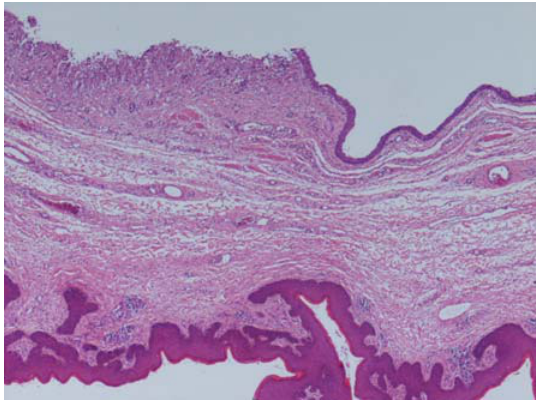
FIGURE 2 . Epidermis covering the polyp is seen at the bottom of the picture. The columnar epithelium lining the cyst is seen at the top with an adjacent area of erosion of epithelium with foamy macrophages. Magnification × 40.